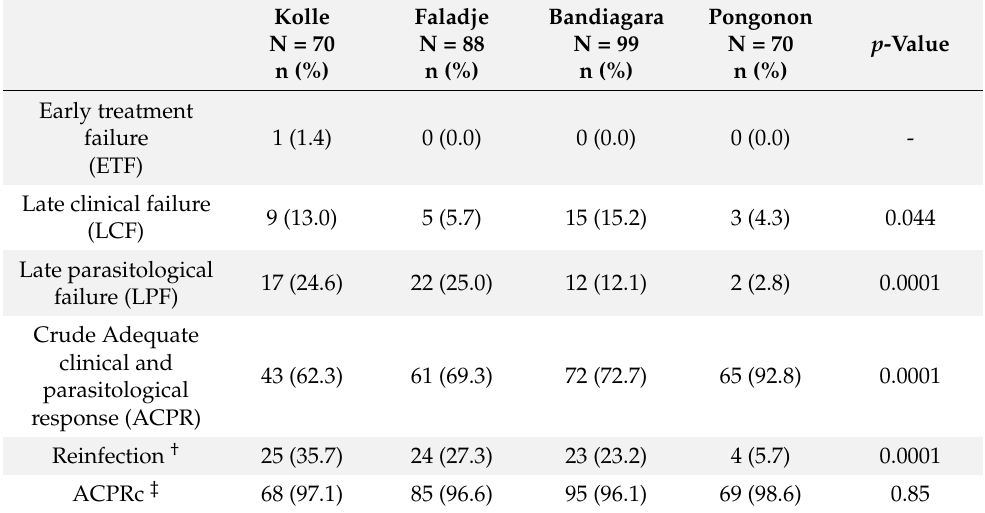
Table 2. Primary treatment outcomes.